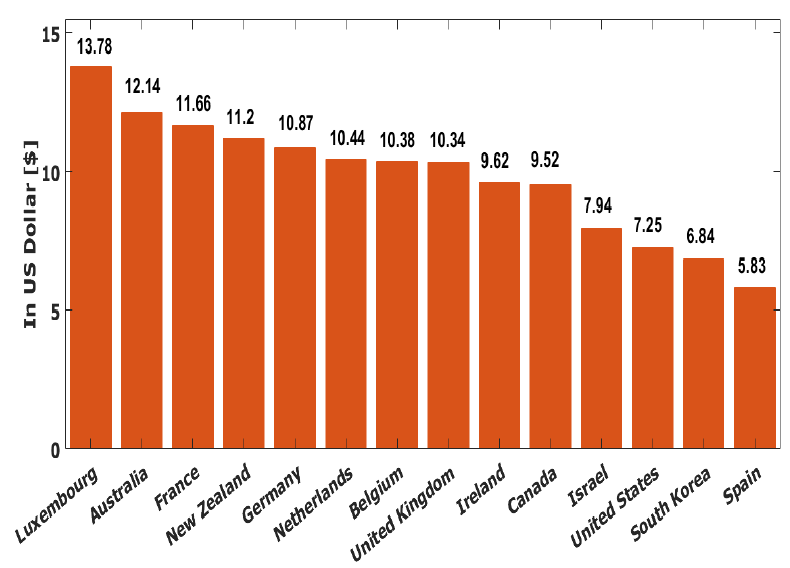
Figure 13. Hourly minimum wage for different industrialized countries